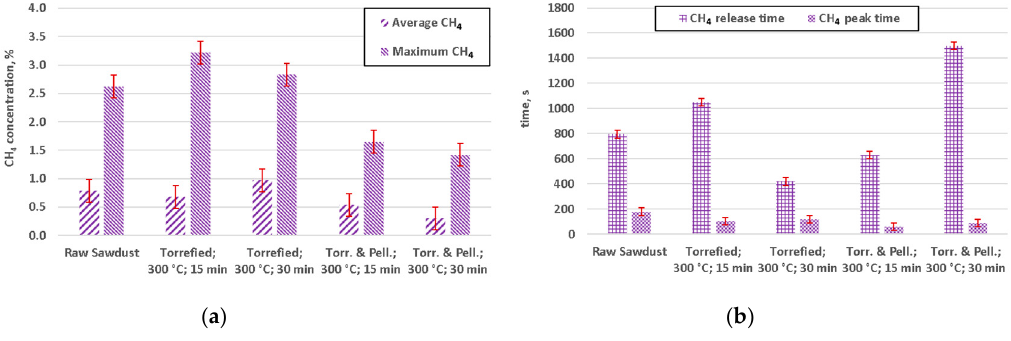
Figure 9. CH 4 concentration for preformed gasification experiments: ( a ) average concentrations of methane; ( b ) release time and the time of peak concentration (Torr. & Pell. – torrefied and pelletized).